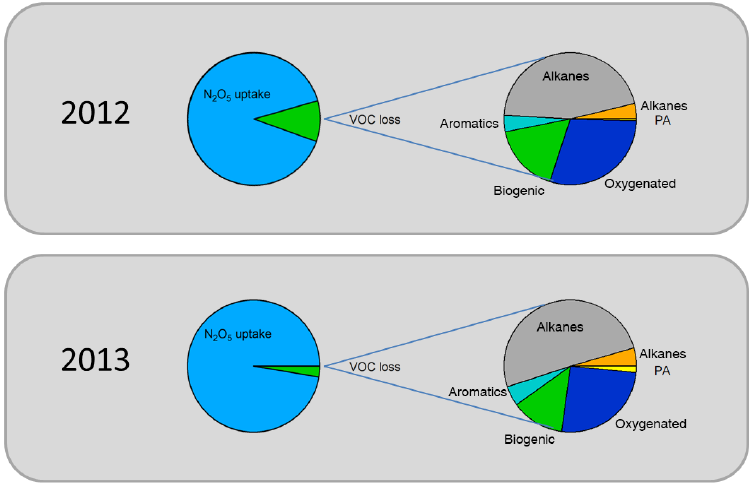
Figure 8. Contributions to NO 3 reactivity. In both years, formation of N 2 O 5 and consequent uptake to aerosol dominate NO 3 loss, and reactions with VOCs are primarily with alkanes. For comparison, the total NO 3 loss rate was 0.016s − 1 in 2012 and 0.118s − 1 in 2013.